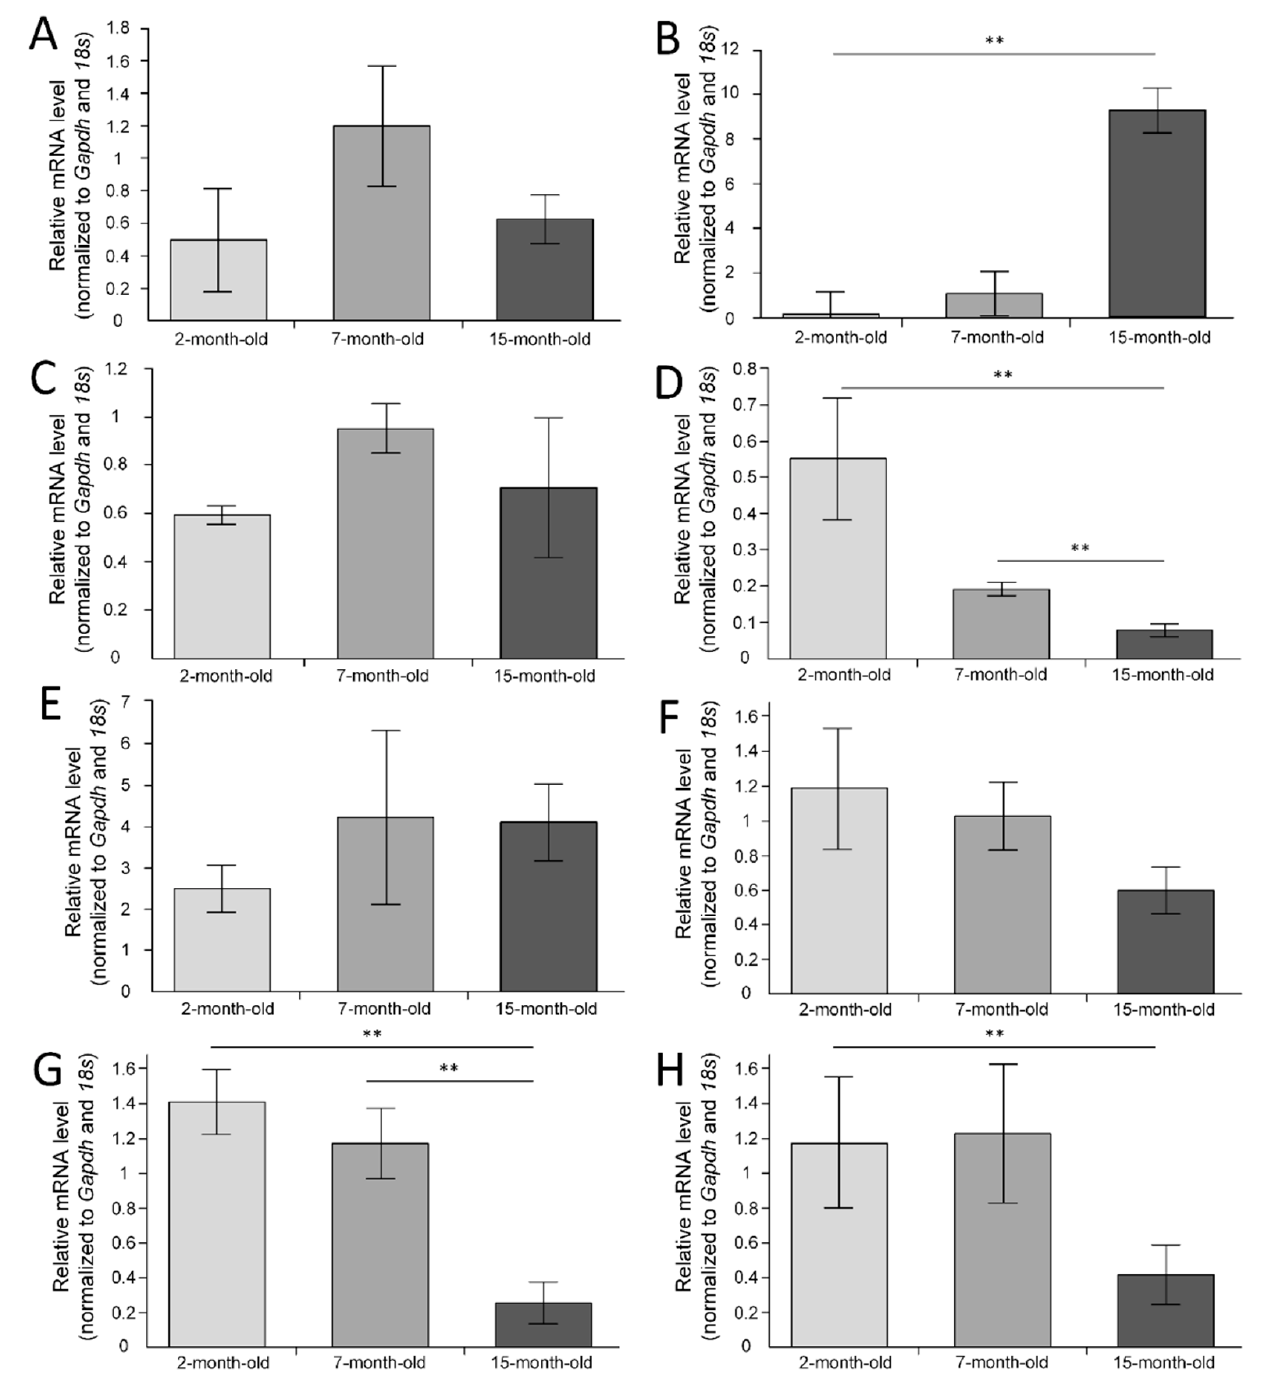
Figure 2. The normalized gene expression in the cerebral cortex: ( A ) Bdnf ; ( B ). Il1b ; ( C ) Nrf1 ; ( D ) Nfe2l2 ; ( E ) Cox1 ; ( F ) Tfam ; ( G ) Sod2; ( H ) p62 . ** p < 0.01 differences between age groups were statistically significant according to the Mann–Whitney test. The 2-month-old mice (n = 9), 7-month- old mice (n = 9), 15-month-old mice (n = 9).